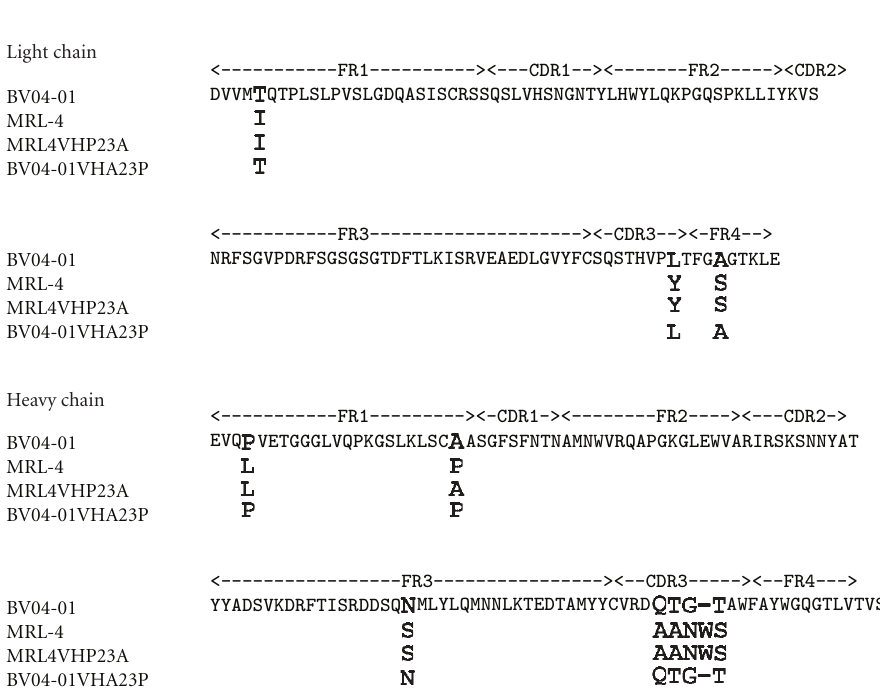
Figure 1: Amino acid sequences alignment of the light and heavy chain variable regions of the antibodies BV04-01, MRL-4, and their mutants.